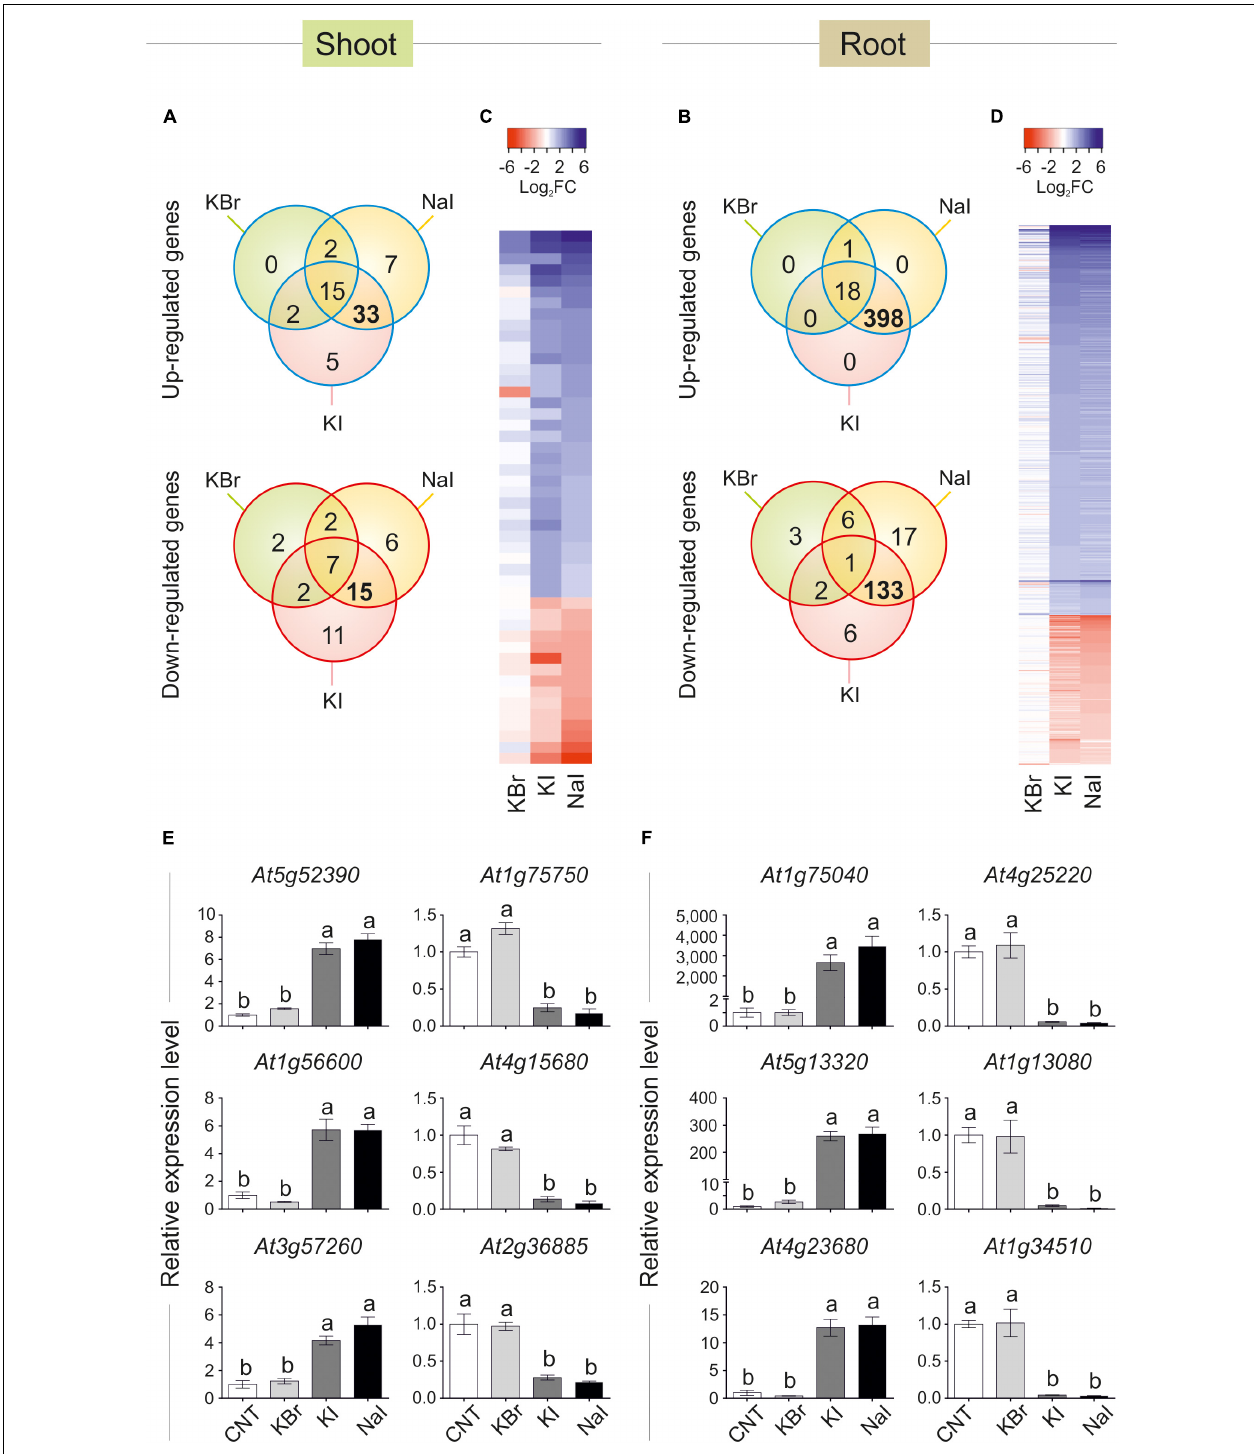
FIGURE 3 | Transcriptional regulation of gene expression induced by iodine. Venn diagram showing the number of genes differentially regulated in shoot (A) or root (B) tissues of KBr-, NaI-, and KI-treated plants (10 µ M—48 h), when compared with the control. Heatmap showing the pattern of expression of the genes analysed in the shoot (C) or root (D) tissues in response to NaI, KI or KBr treatments, when compared with the control. qPCR validation of selected genes up- or down-regulated by iodine treatments (commonly regulated by NaI and KI, but not KBr) in shoot (E) or root (F) tissues. qPCR data are mean ± SE of four biological replicates, each composed of a pool of three different rosettes. Values indicated by different letters significantly differ from each other (according with one-way ANOVA, LSD post hoc test, P ≤ 0.05).